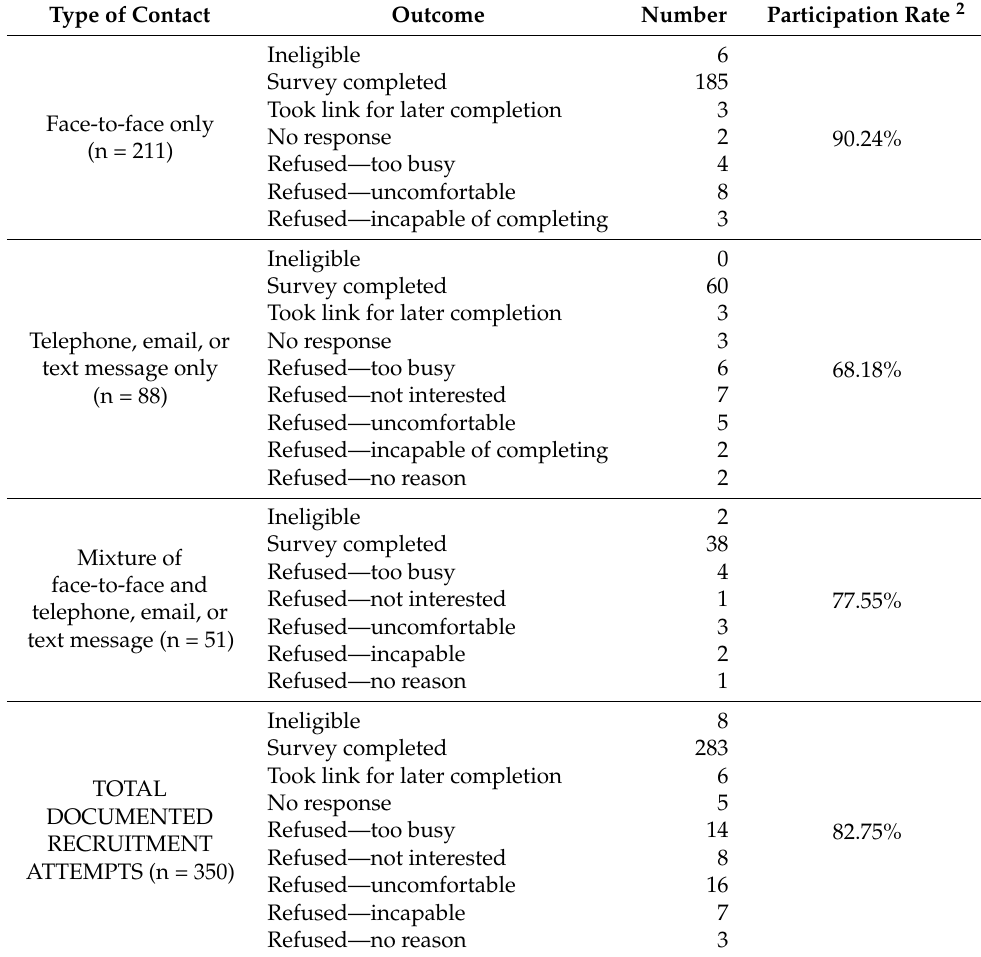
Table 7. Participation rates for recruitment conducted among personal/organizational networks 1